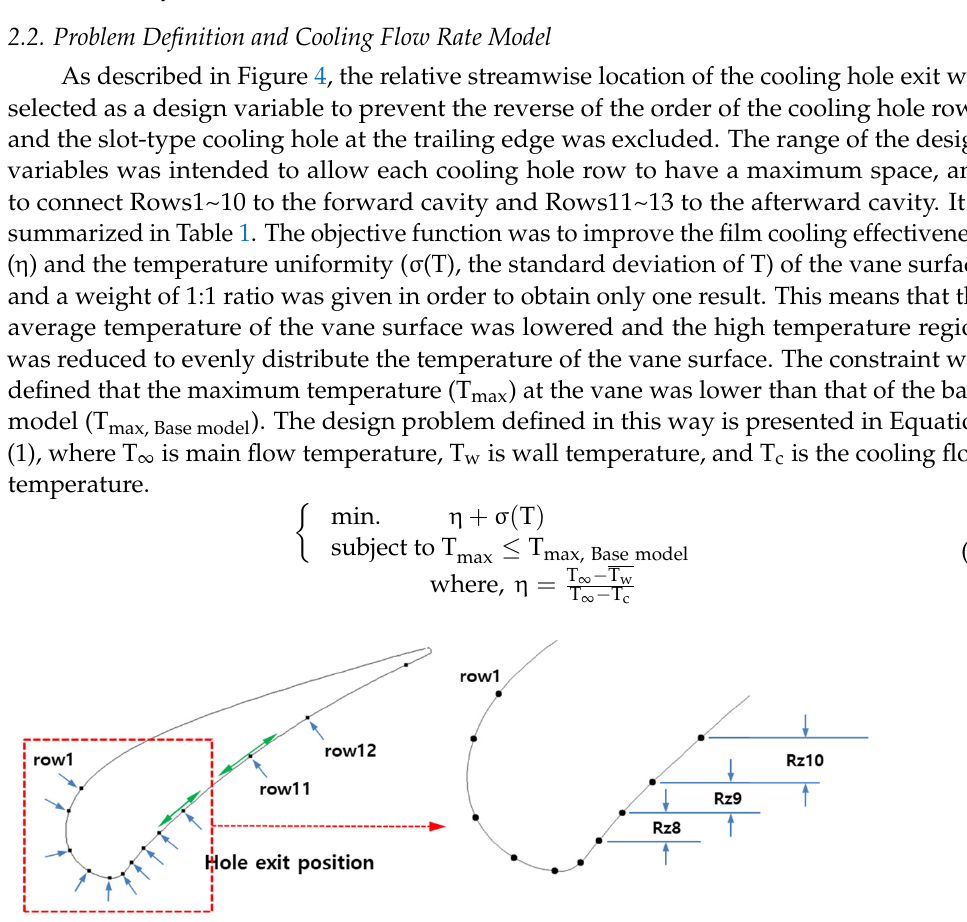
Figure 3. Cooling hole array (reprinted with permission from [16]; copyright 2021 Korean Society for Fluid Machinery).